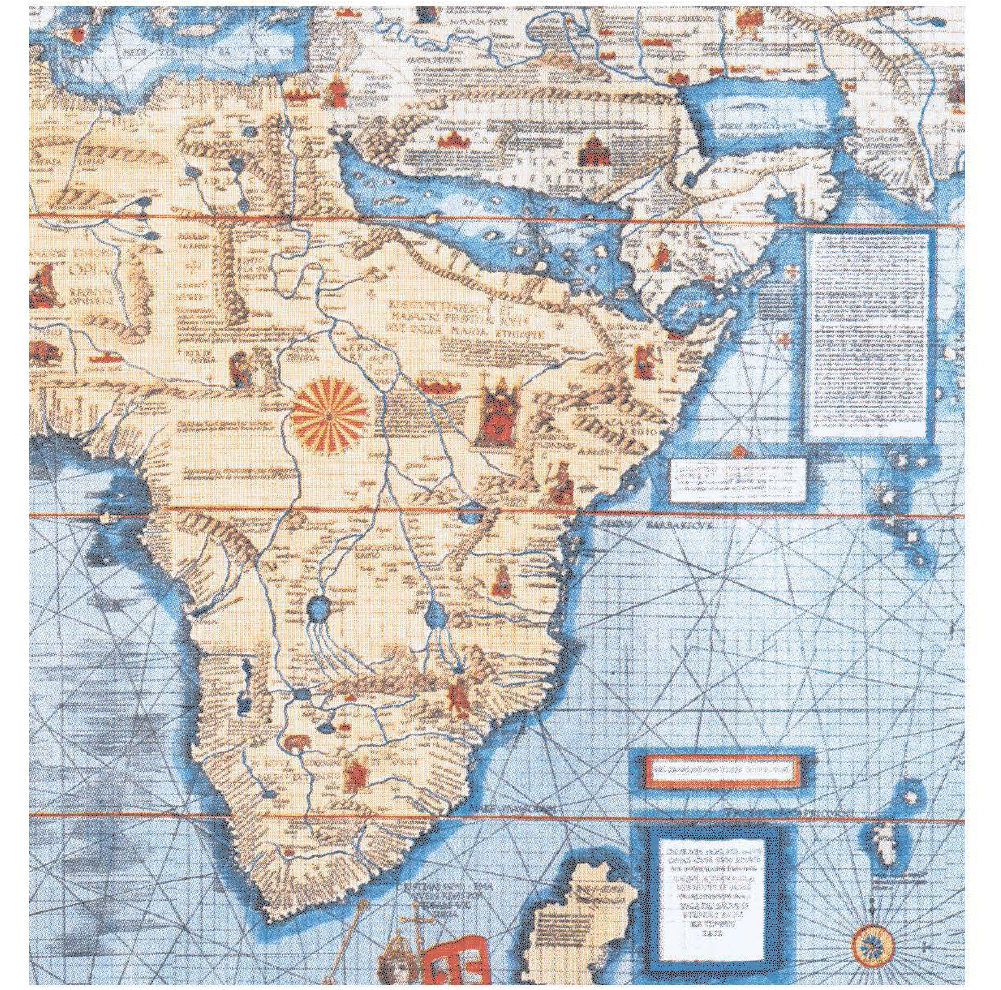
Figure 3: Ca11a Marina [detail]. Waldseemiiller, Martin (1516). "Carta Marina" [inap],